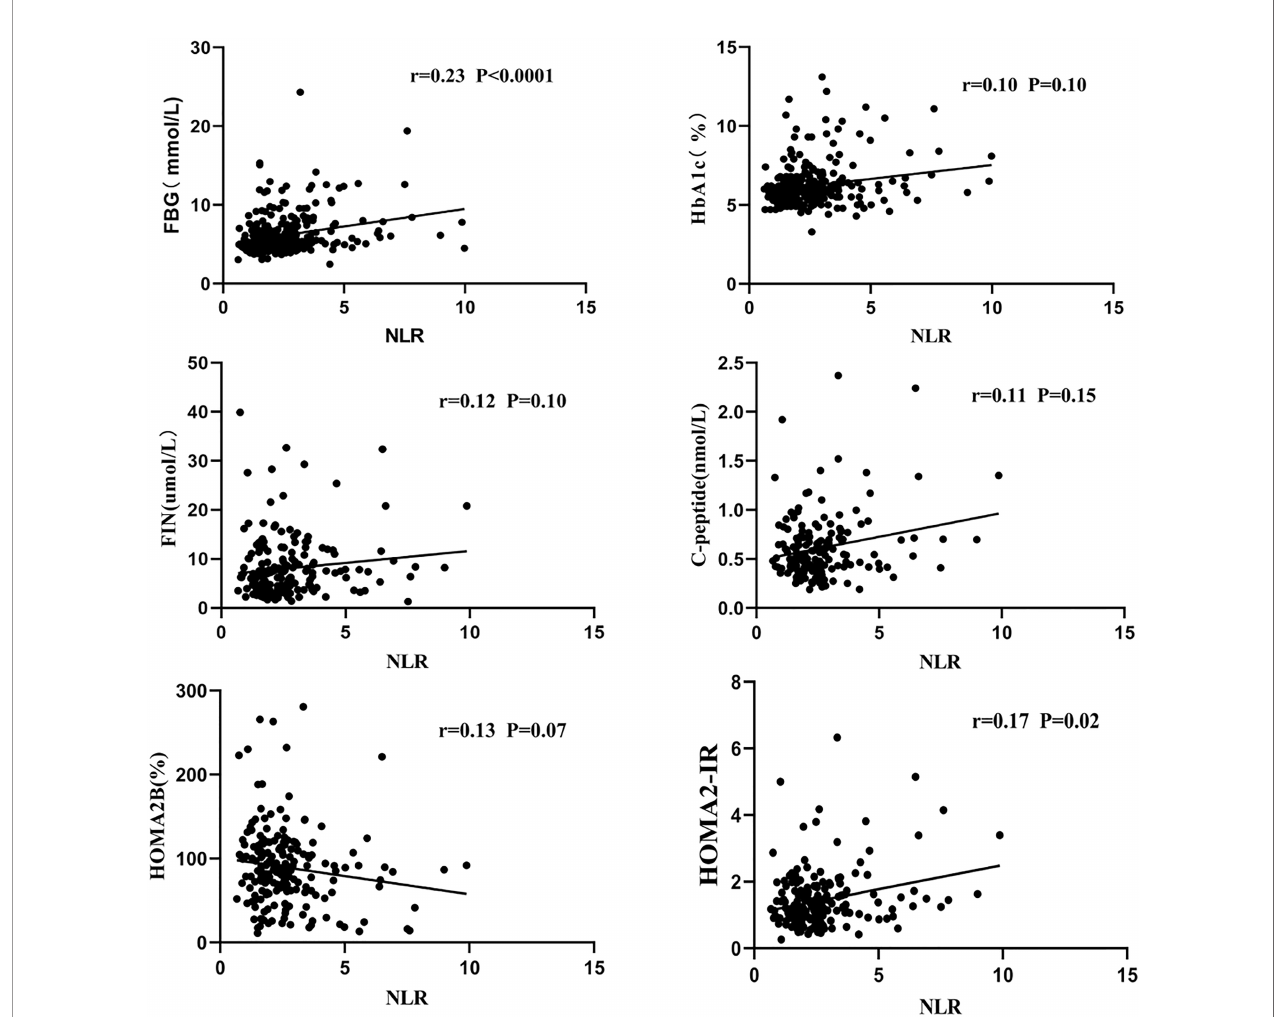
FIGURE 1 | A scatter plot of the Spearman correlation analysis between the NLR and glucose-related